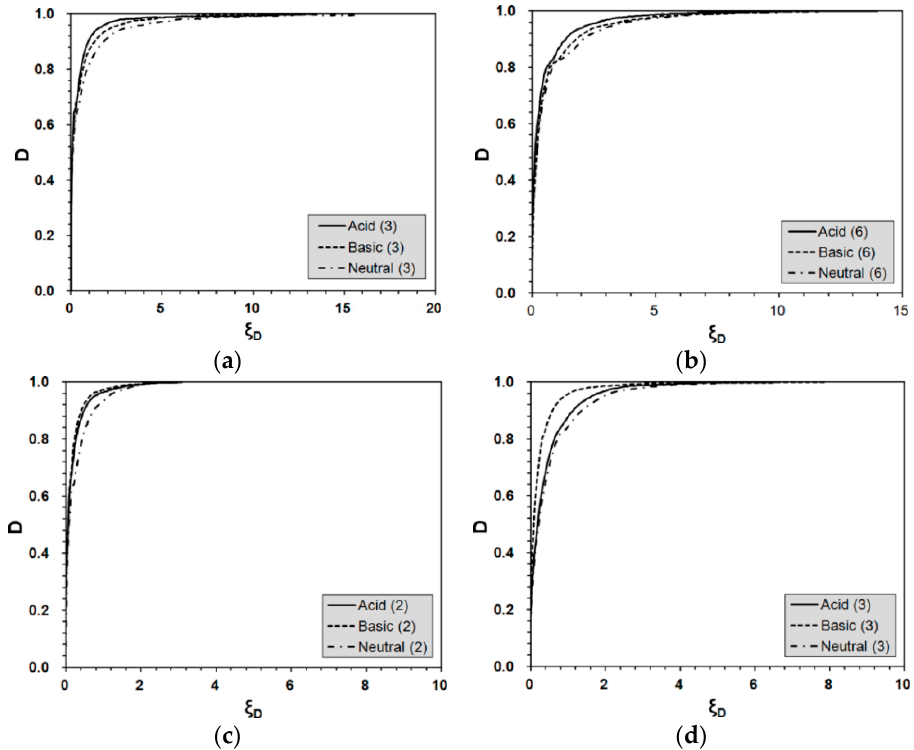
Figure 7. Typical disturbance function curves: ( a ) 30 days submersion, 0.3 MPa of normal stress; ( b ) 30 days submersion, 0.6 MPa of normal stress; ( c ) 850 days submersion, 0.3 MPa of normal stress; ( d ) 850 days submersion, 0.6 MPa of normal stress.